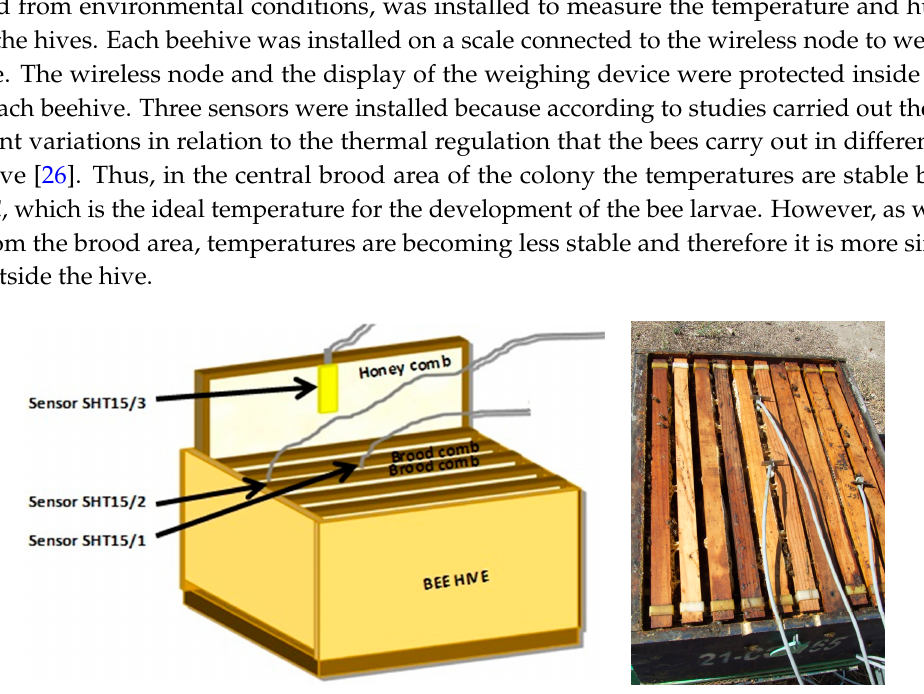
Figure 17. ( a ) Location of the SHT15 sensors in the hives; ( b ) Photograph of the hive.